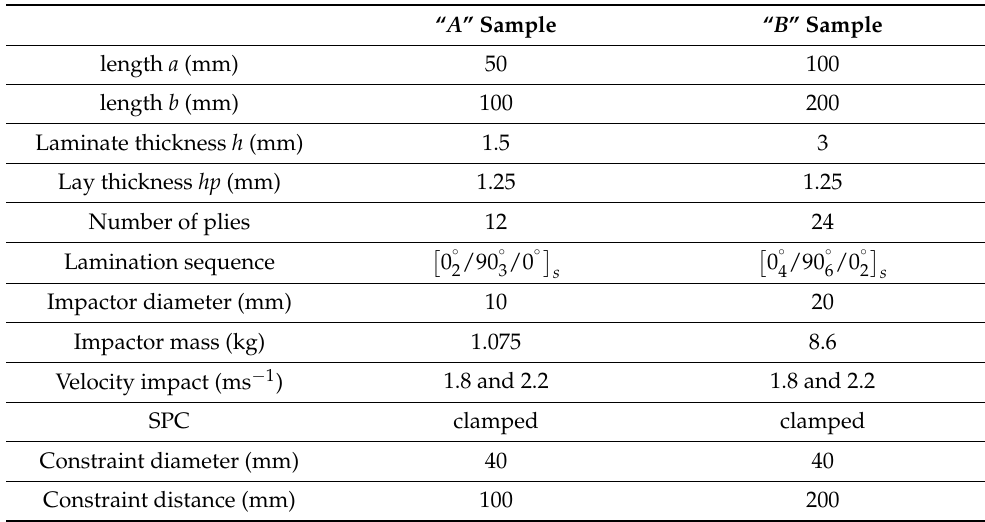
Table 4. Experimental